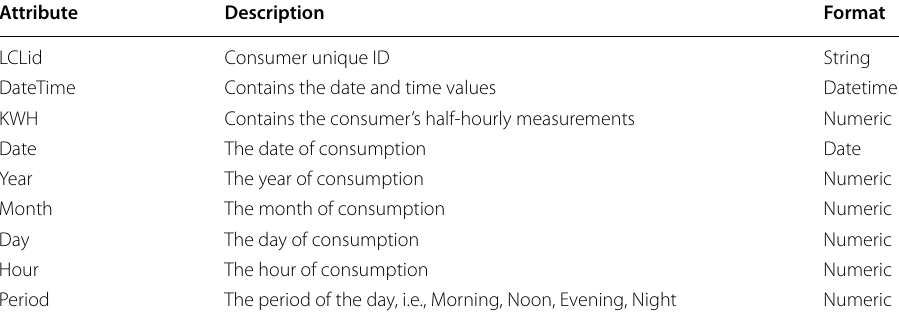
Table 2 Dataset attributes and description